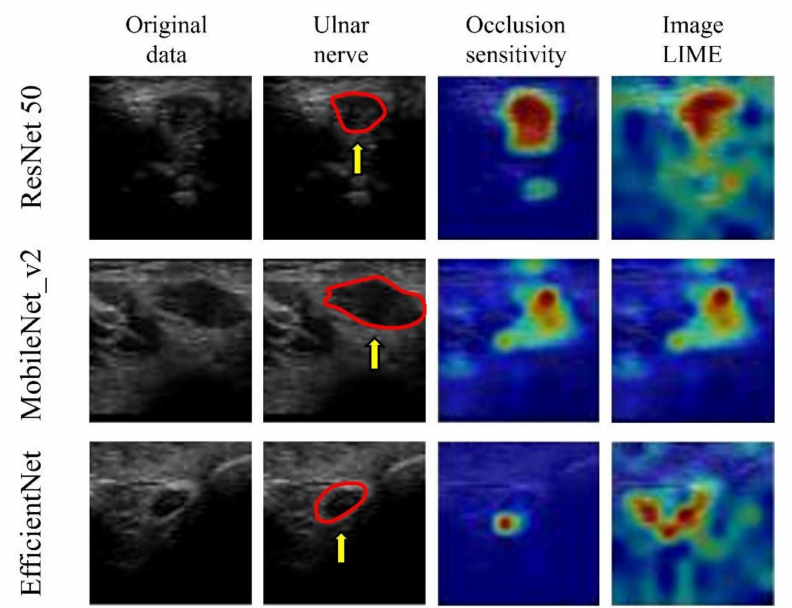
Figure 10. Visualization of the region of interest using occlusion sensitivity and image LIMEs. Learning models focus on neural interior and perineural tissues. The red circle is a cross section of the ulnar nerve in the original image. AI focused on hyperechoic changes in the ulnar nerve epithelium and hypoechoic changes in the ulnar nerve interior and surrounding